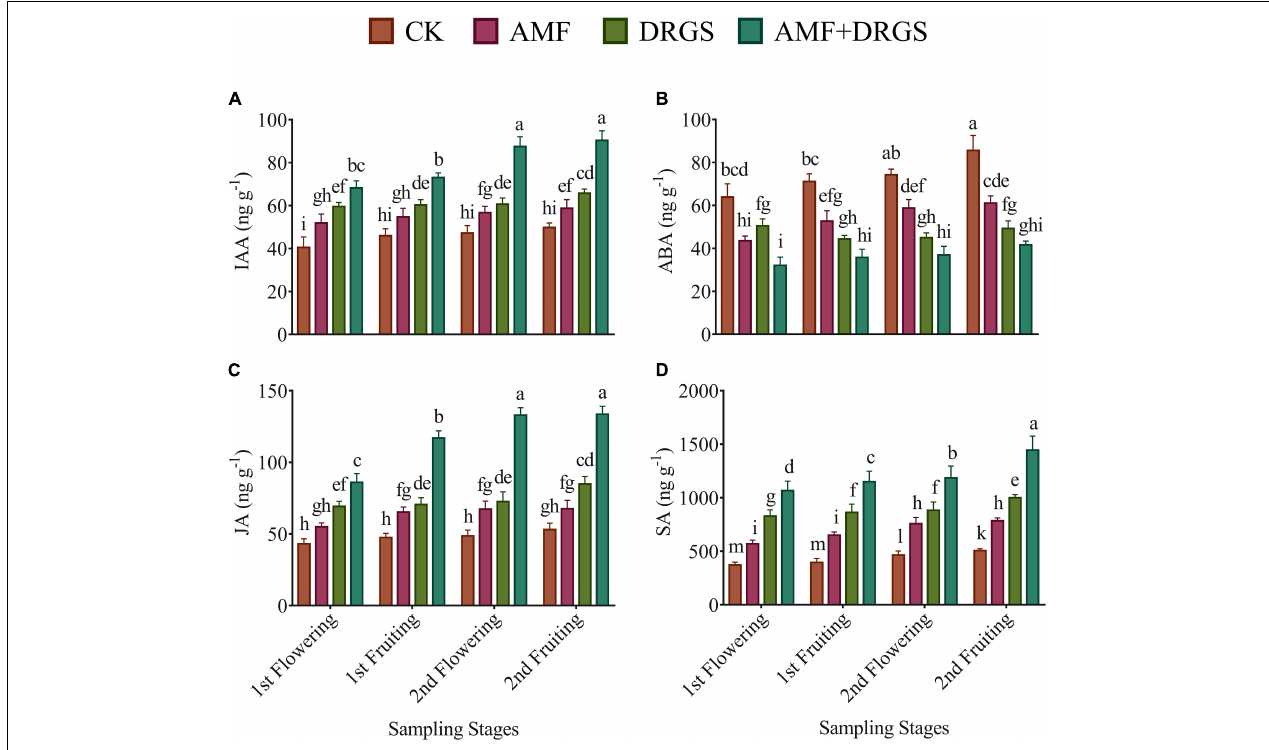
FIGURE 8 | Effect of AMF inoculation and amendment with dry raw garlic stalk on phytohormones. Indoleacetic acid (IAA) (A) , abscisic acid (ABA) (B) , jasmonic acid (JA) (C) , salicylic acid (SA) (D) on eggplant leaves at 1st flowering, 1st fruiting, 2nd flowering, and 2nd fruiting stages. Data represent the mean of ± SE ( n = 5). Different letters show significant differences within treatments. Tukey’s HSD test was employed to verify statistical significance at p < 0.05. TABLE 2 | Effect of AMF inoculation and DRGS treatment on mineral nutrients in eggplant leaves and phytohormones in roots.